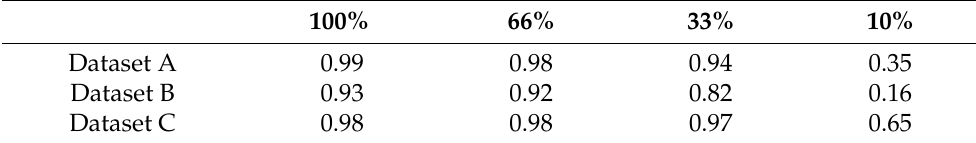
Table 7. Acc by changing the total number of samples.